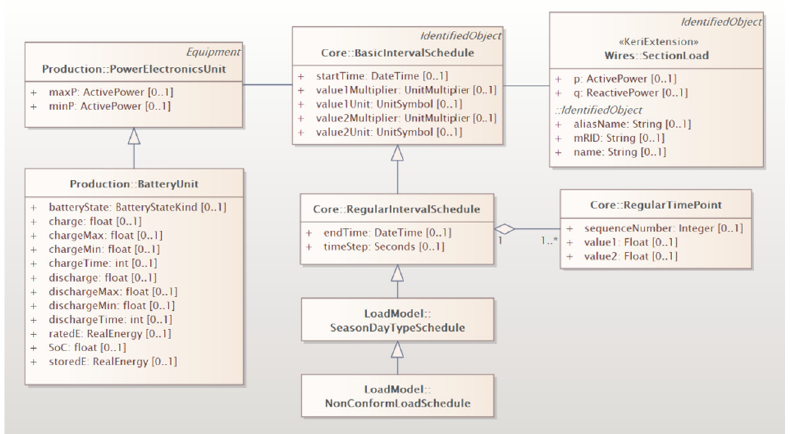
Figure 14. A UML diagram of the prediction of generation and load.